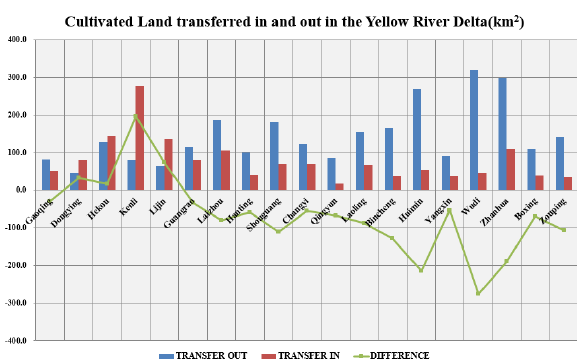
Figure 8. Cultivated Land transferred in and out in the Yellow River Delta